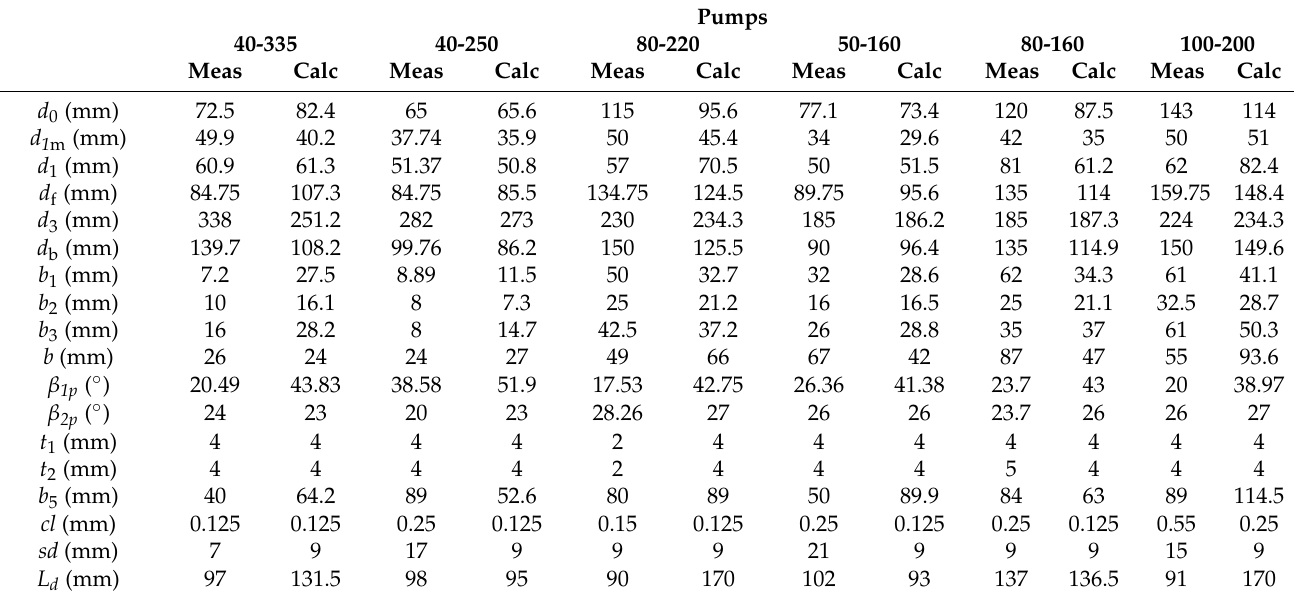
Table 6. Geometric parameters measured and calculated by the